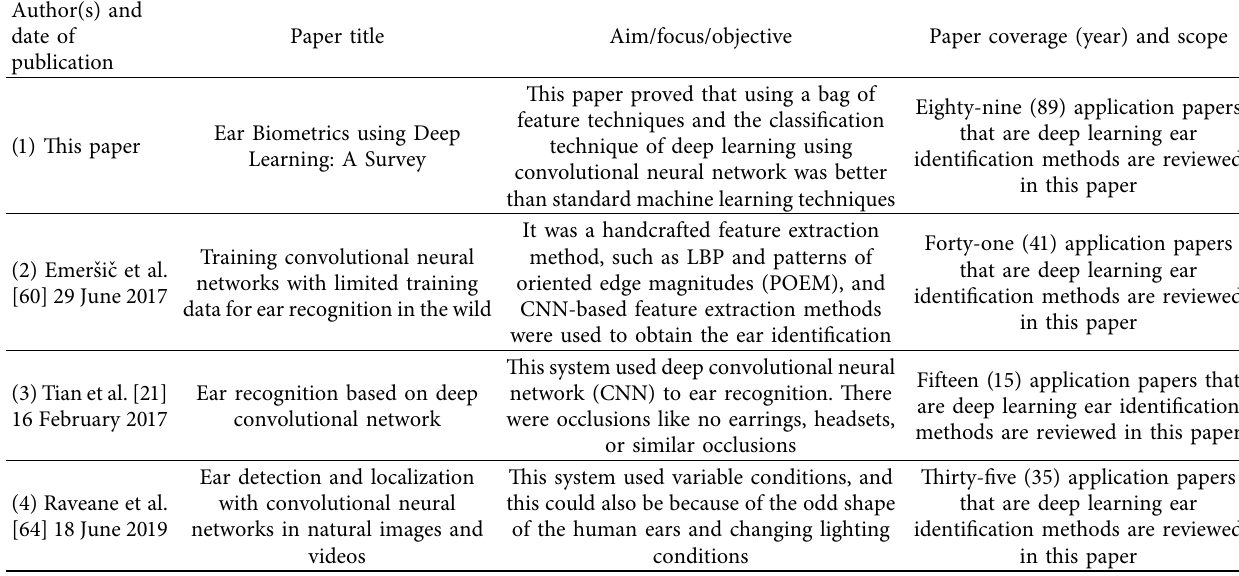
Table 7: Differences between this review article and the recent/existing review